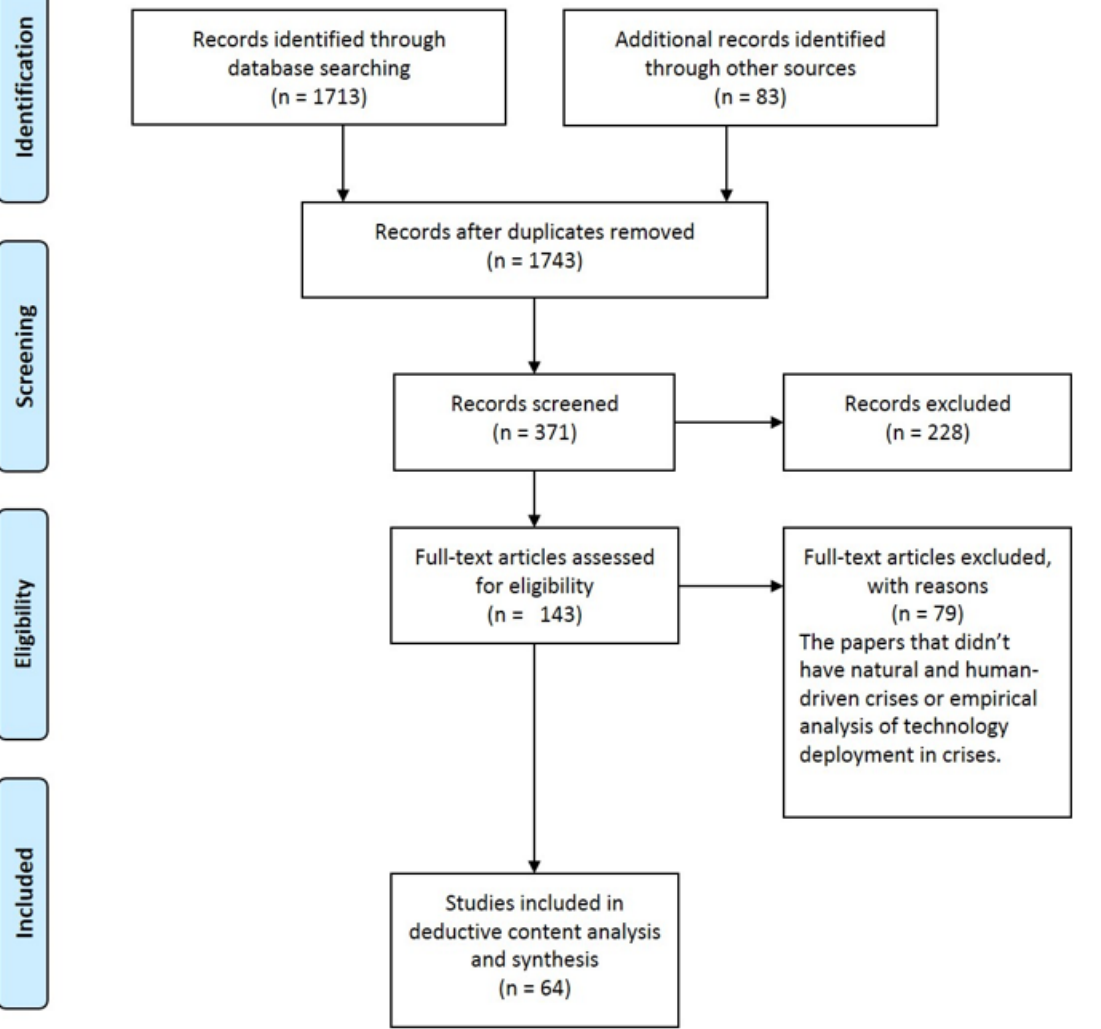
Figure 1. The PRISMA diagram showing various steps taken for the purpose of this systematic review